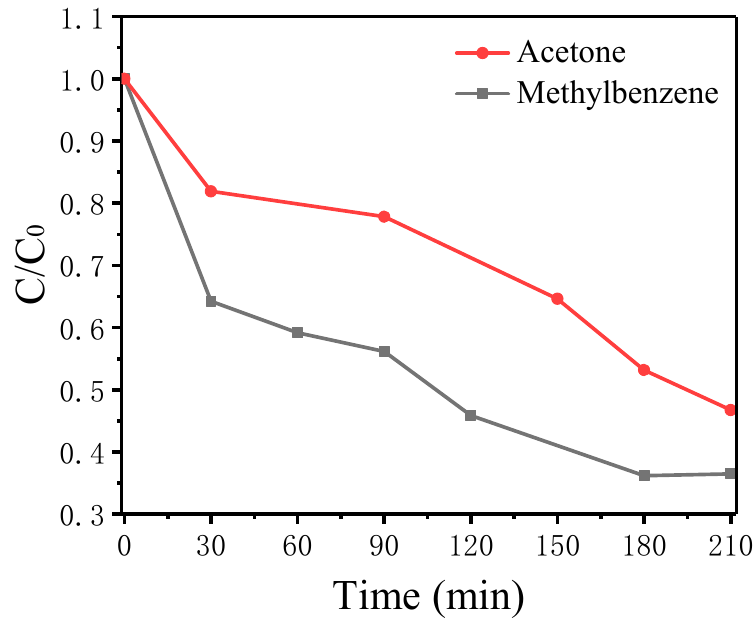
Figure 12. Photodegradation of gaseous methylbenzene and gaseous acetone over TiO 2 (30%)/ZnO(10%)/diatomite under visible light.